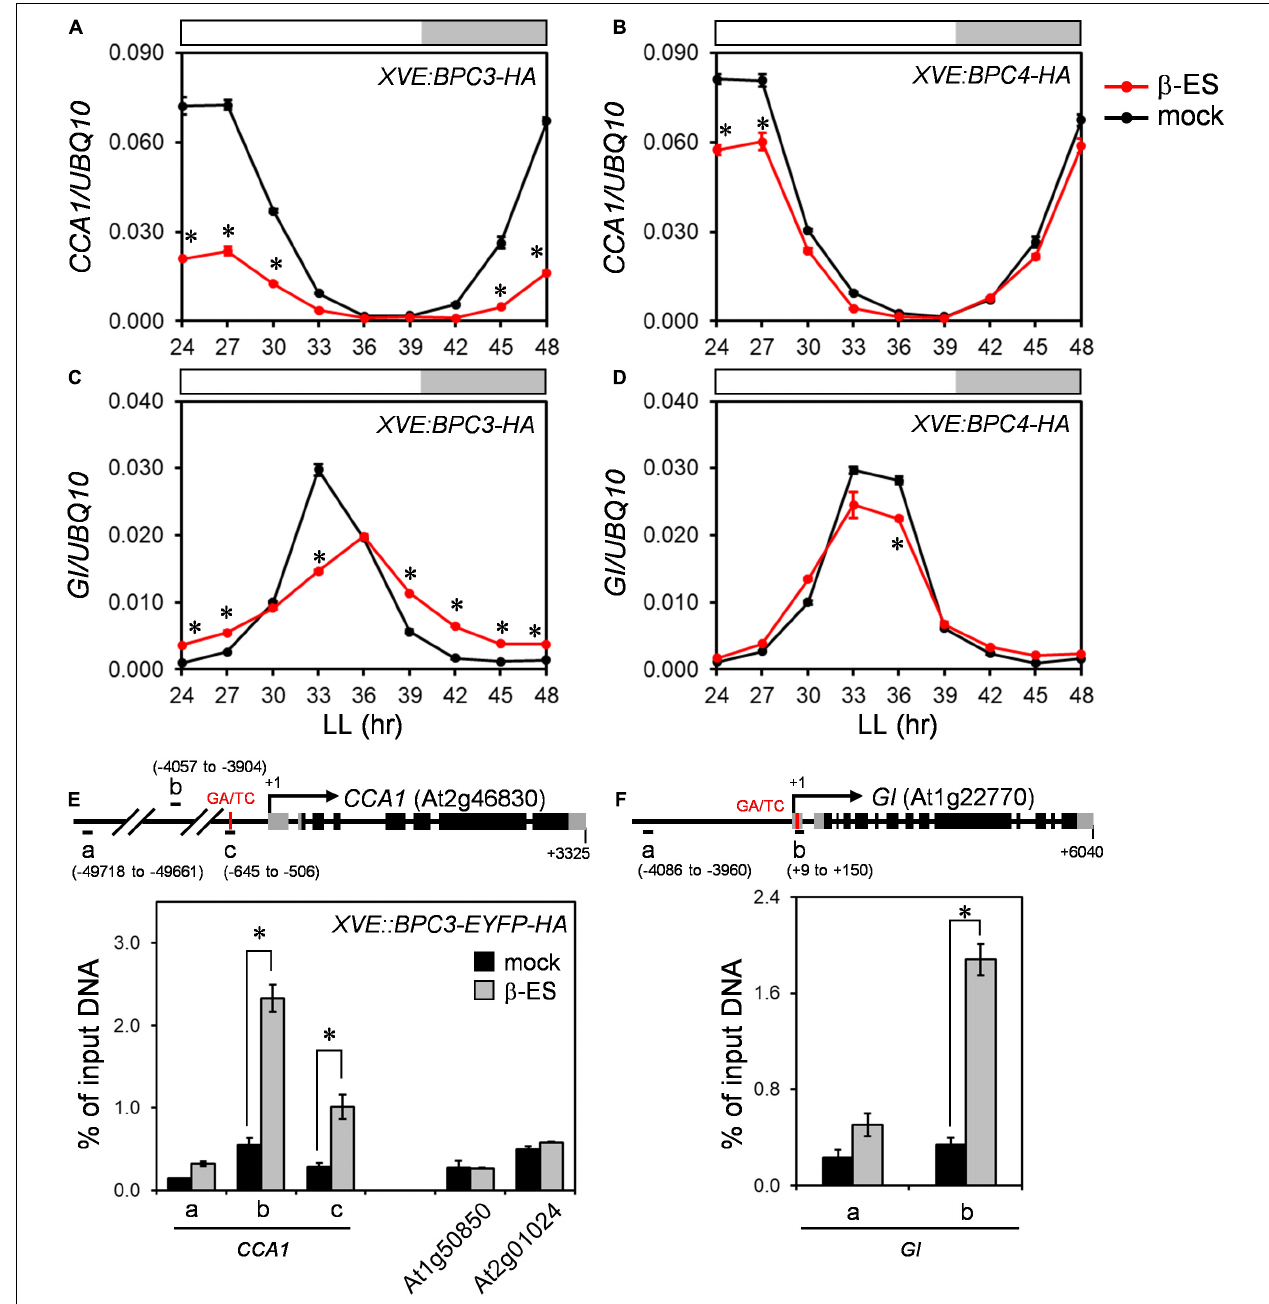
FIGURE 6 | BPC3 is upregulated in the bpc1,2,4,6 and is a negative regulator for CCA1. (A–D) Twelve-day-old plants of XVE:BPC3-HA and XVE:BPC4-HA transgenic lines were treated with 0 (mock) or 50 µ M β -estradiol ( β -ES) for 24 h when released to LL and harvested at indicated times for profiling CCA1 (A,B) and GI (C,D) by qRT-PCR analyses. Data are means ± S.E. ( n = 3 technical replicates; one independent biological replicate was presented in Supplementary Figure 7 ). Asterisks indicate transcript levels were significantly changed by the β -ES treatment (Student’s t- test; ∗ P < 0.05). (E) BPC3 was associated with the CCA1 promoter in vivo . Leaves of 22-day-old XVE:BPC3-EYFP-HA transgenic plants grown under LD were treated with 0 (mock) or 50 µ M β -estradiol at ZT9 for one day and fixed to conduct ChIP-qPCR analyses by using an anti-HA antibody. The diagram shows the translation start site and exons of CCA1 gene structure and upstream region. Gray and black boxes represent untranslated and coding regions, respectively. The amplicons “a,” “b,” and “c” for ChIP-qPCR are indicated by horizontal black bars. Numbers indicate the positions relative to the transcriptional start site + 1 of CCA1 . Data are mean ± S.E. ( n = 3). Transposable elements At1g50850 and At2g01024 were used as negative controls. Asterisks indicate that amplicons were at least three-fold enriched by the BPC3-EYFP-HA induction significantly (Student’s t- test; ∗ P < 0.01). (F) Chromatin immunoprecipitation qPCR was conducted as described in panel (E) . The diagram shows GI gene structure with the amplicons “a” and “b” for ChIP-qPCR assays. Data are mean ± S.E. ( n = 3). The asterisk indicates that the amplicon was significantly enriched upon the BPC3-EYFP-HA induction (Student’s t- test; ∗ P < 0.001). An independent biological replicate conducting the GA/TC association tests was shown in Supplementary Figure 7F